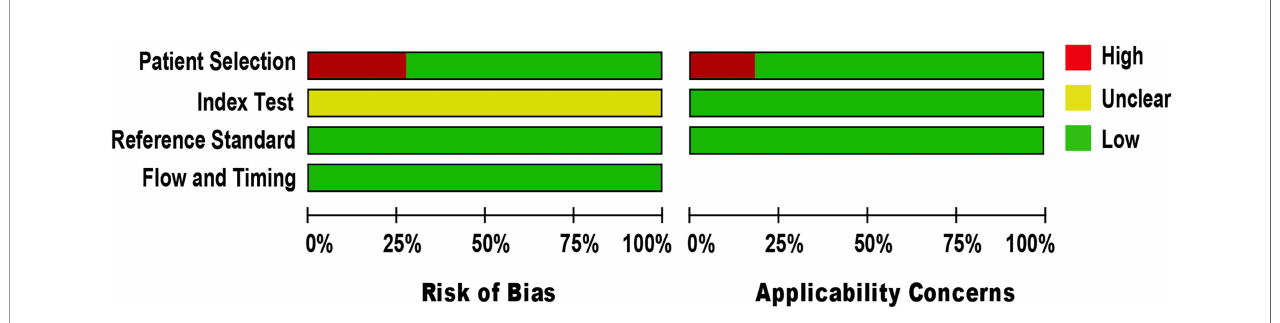
FIGURE 2 | Methodological quality and risk of bias assessment of the eligible